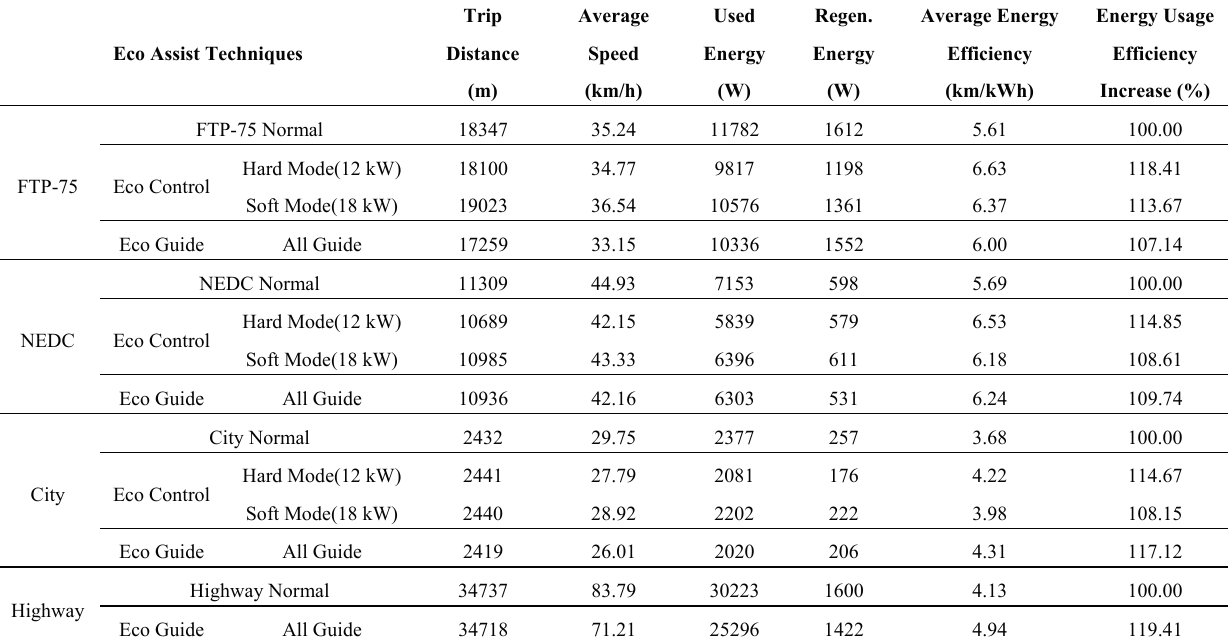
Figure 8. Test result ( a ) FTP-75 mode; ( b ) NEDC mode; ( c ) City mode; ( d ) Highway mode. Table 3. Test result of energy usage efficiency